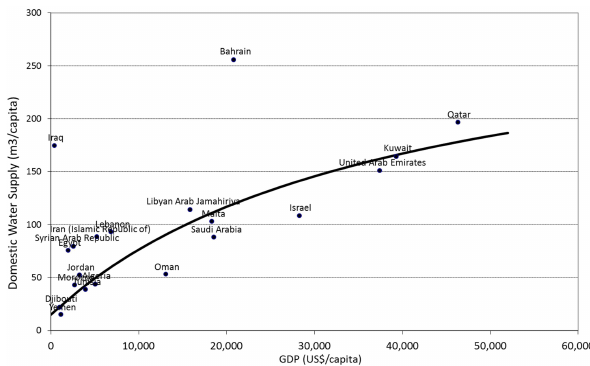
Fig. 4. Relationship between per capita domestic water withdrawals and